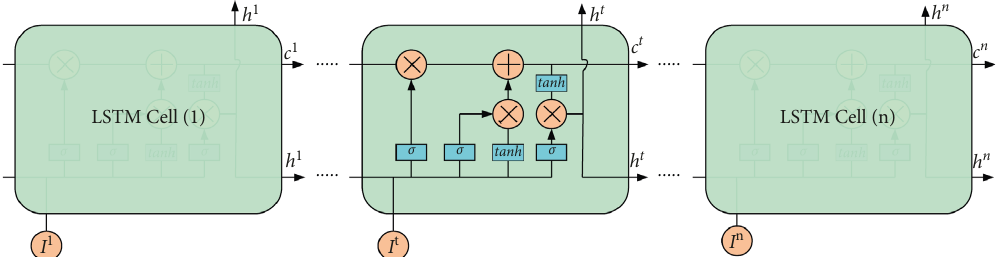
Figure 6: Structure of a long short-term memory model.